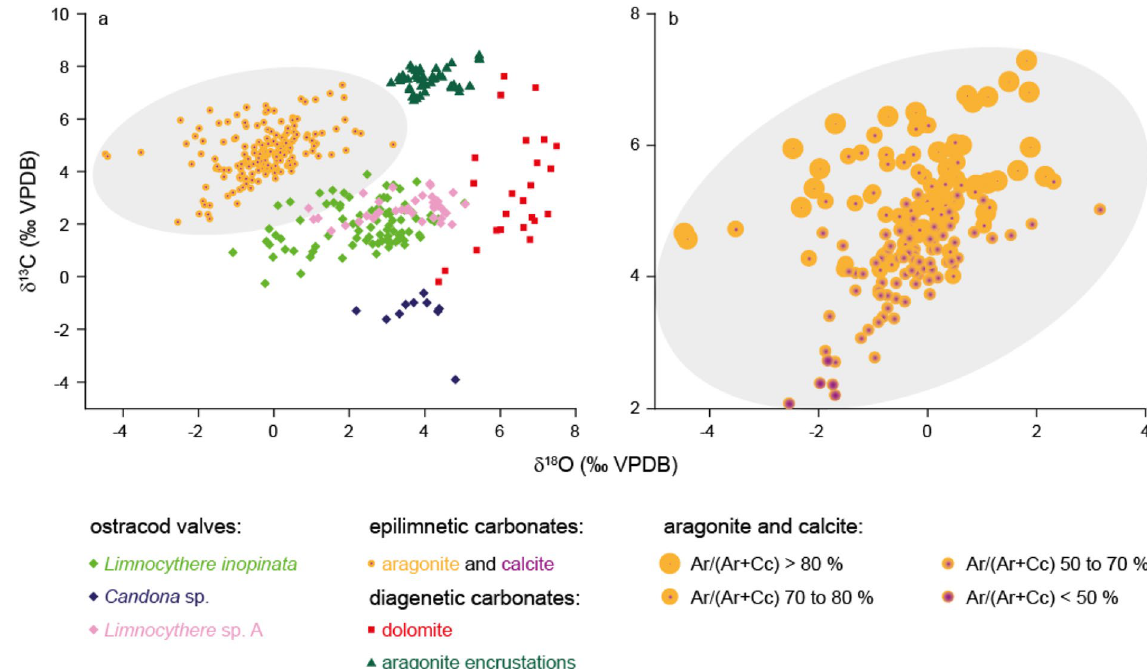
Figure 4. δ 13 C versus δ 18 O plot highlighting the isotopic variability between different carbonate phases in Lake Van. ( a ) Each carbonate phase plots in different fields suggesting different precipitation environments. Dolomite data from McCormack et al. 25 , epilimnetic aragonite and calcite data from McCormack et al. 14 and ostracod isotopy from McCormack et al. 31 . ( b ) Isotopic variability between epilimnetic aragonite and calcite showing differences depending on the relative aragonite to calcite content (Ar/(Ar + Cc)) with grey area also depicted in ( a